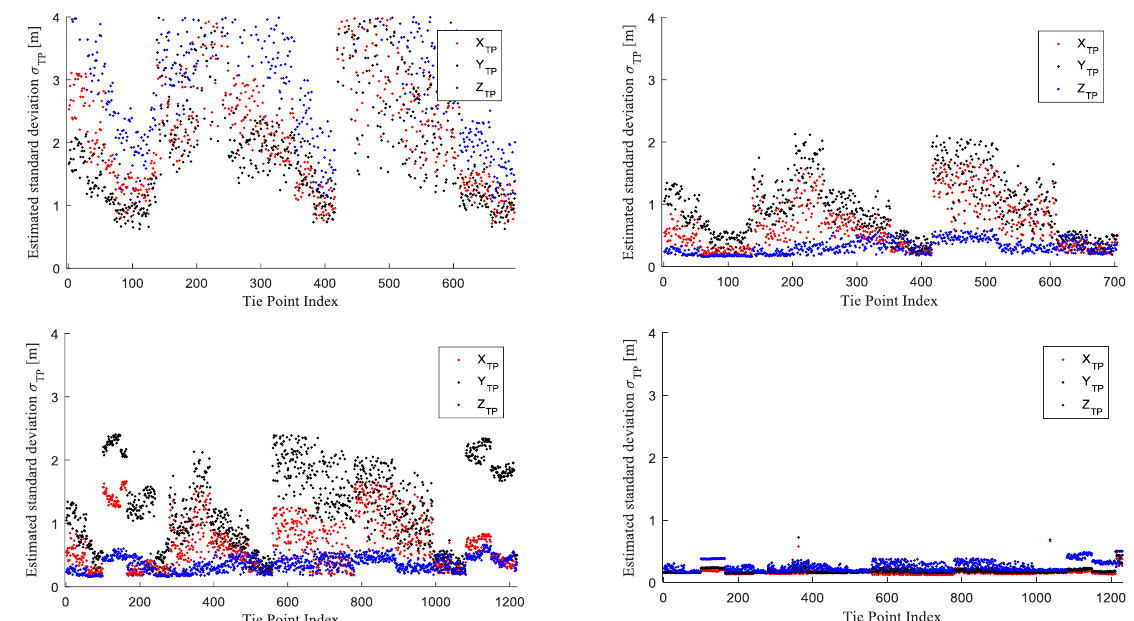
Figure 4: A-posteriori standard deviations of the estimated tie point coordinates in object space from the simulated data after steps 2 (top left), 4 (top right), 5 (bottom left) and 6 (bottom